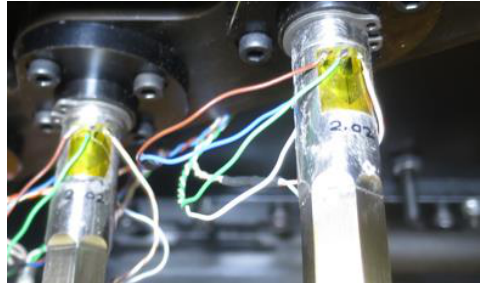
Figure 4. Stain gauge bridges mounted on blades No. 3 and 4.